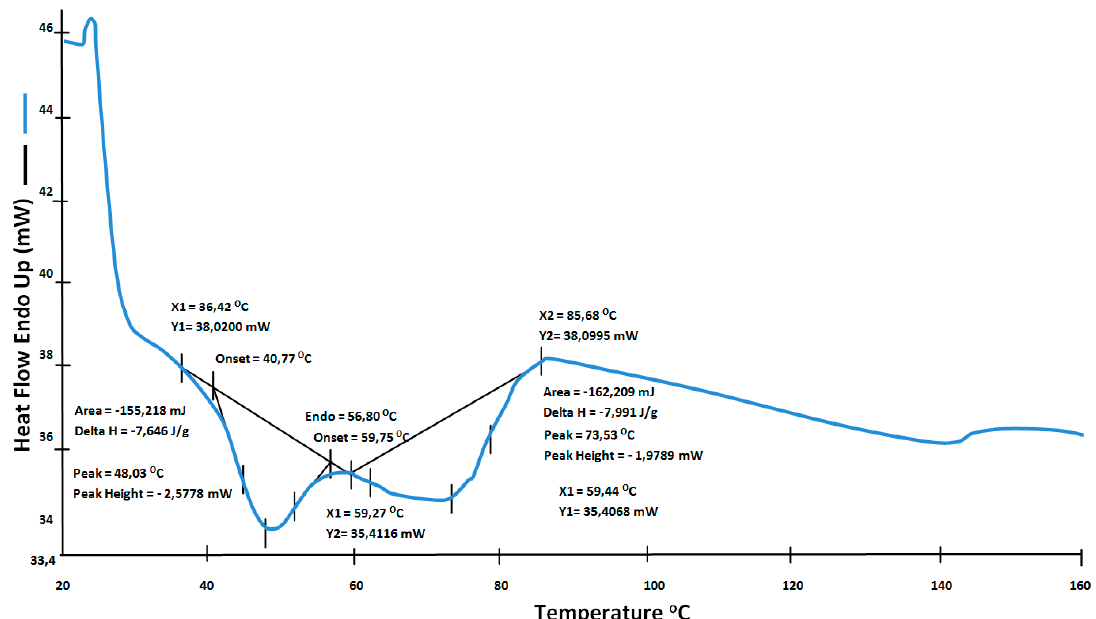
Figure 3. Thermal analysis of the ethylene-vinyl acetate (EVA) probe.